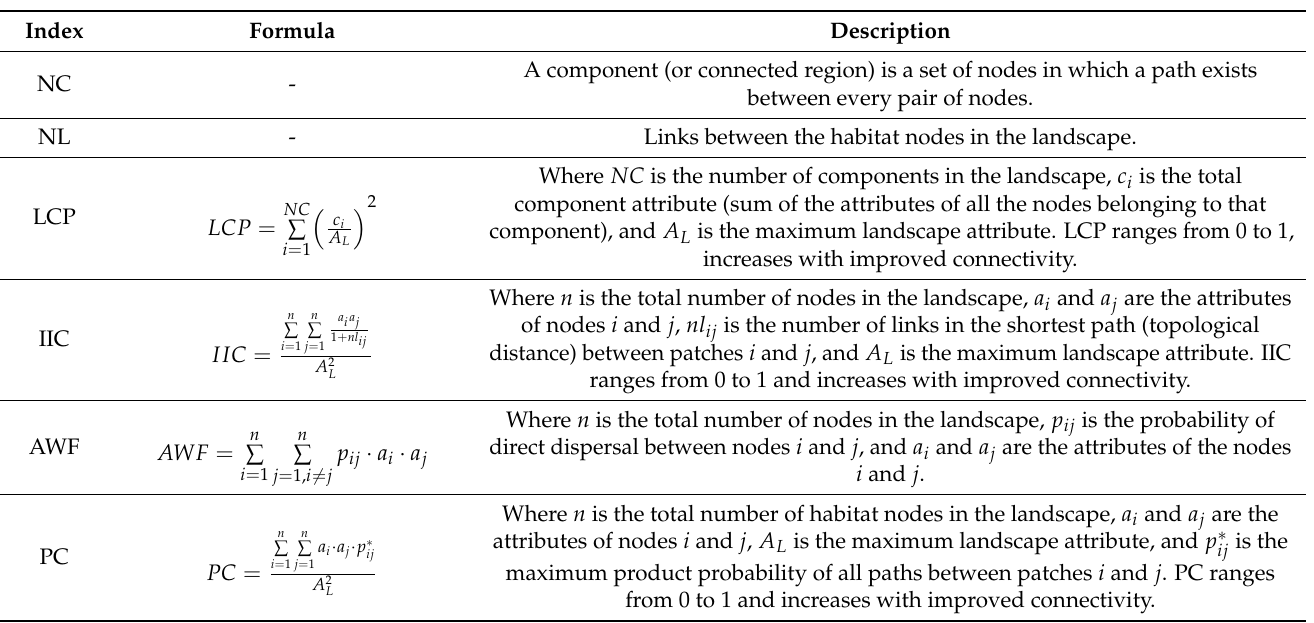
Table 1. Landscape Connectivity